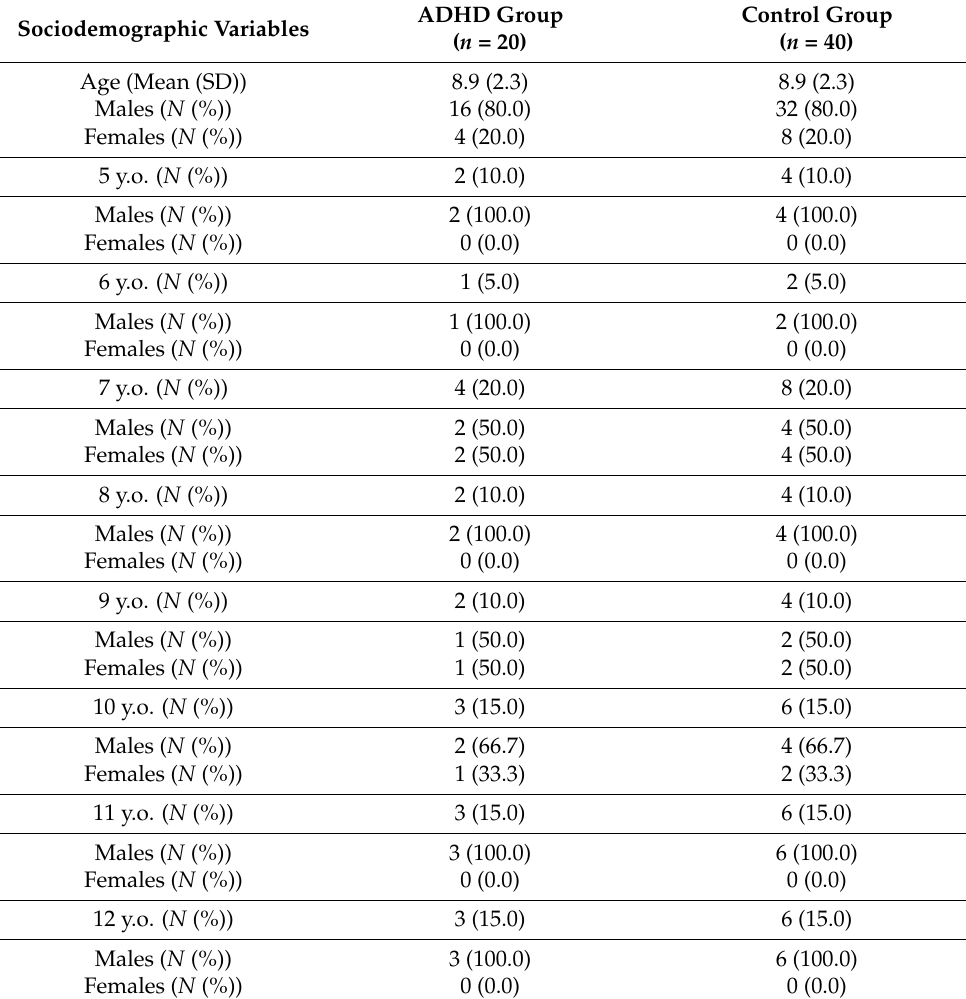
Table A1. Sociodemographic variables of the sample ( n = 60).